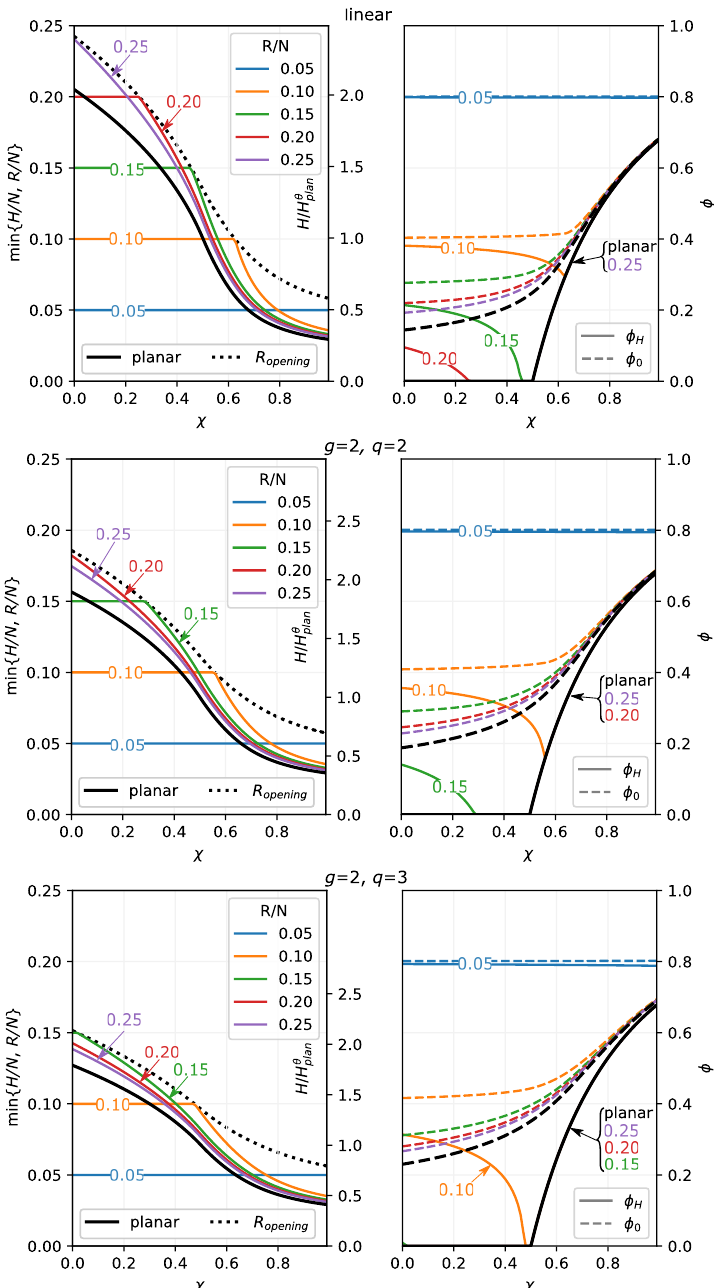
Figure 3. Normalised brush thickness, min { H / N ; R / N } , ( left ) and polymer volume fractions at the edge of the brush, φ ( χ , z = H ) (solid lines) and at the grafting surface φ ( χ , z = 0 ) (dashed lines) as a function of χ -parameter for different pore radius R ( R = 250 (unrestricted); 150; 100; 75; 50) compared with the polymer volume fractions in planar brush with the same N = 1000, σ = 0.02. The upper, middle, and lower rows correspond to brushes of linear chains, and dendrons of the second generations with functionality q = 2 ( middle row) and q = 3 ( lower row), respectively. The pore radii are universally color-coded through all of the frames. Solid black lines correspond to brushes grafted onto the planar surface. The dotted lines in the left frames trace the dependence R opening ( χ , g , q ) on χ . Note the secondary axis with brush thickness normalised as min { H / H plan ; R / H plan θ θ